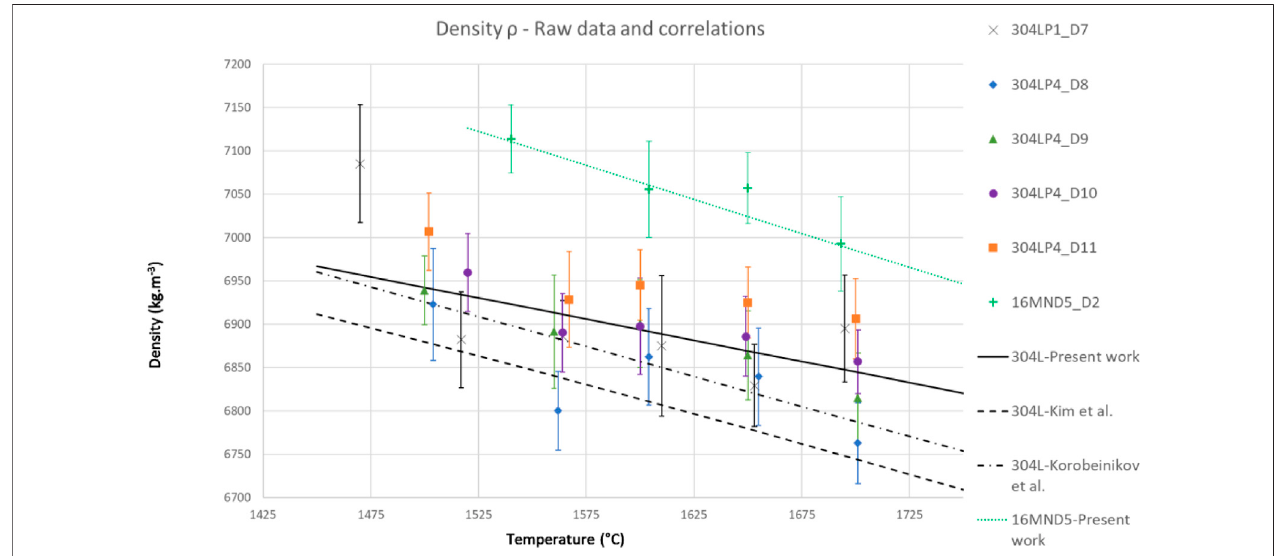
FIGURE 3 | VITI-SD density measurements and comparison with literature for 304L (Korobeinikov, et al., 2021; Kim, 1975).